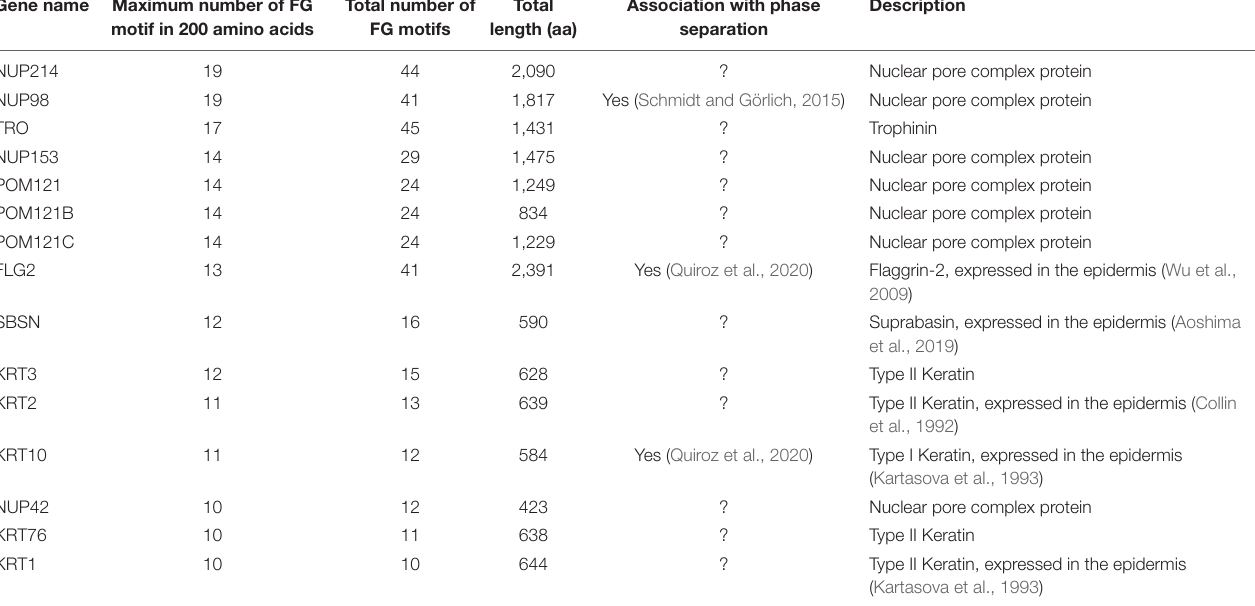
TABLE 2 | The top 15 phenylalanine-glycine (FG)-rich proteins in humans. Gene name Maximum number of FG Total number of motif in 200 amino acids FG